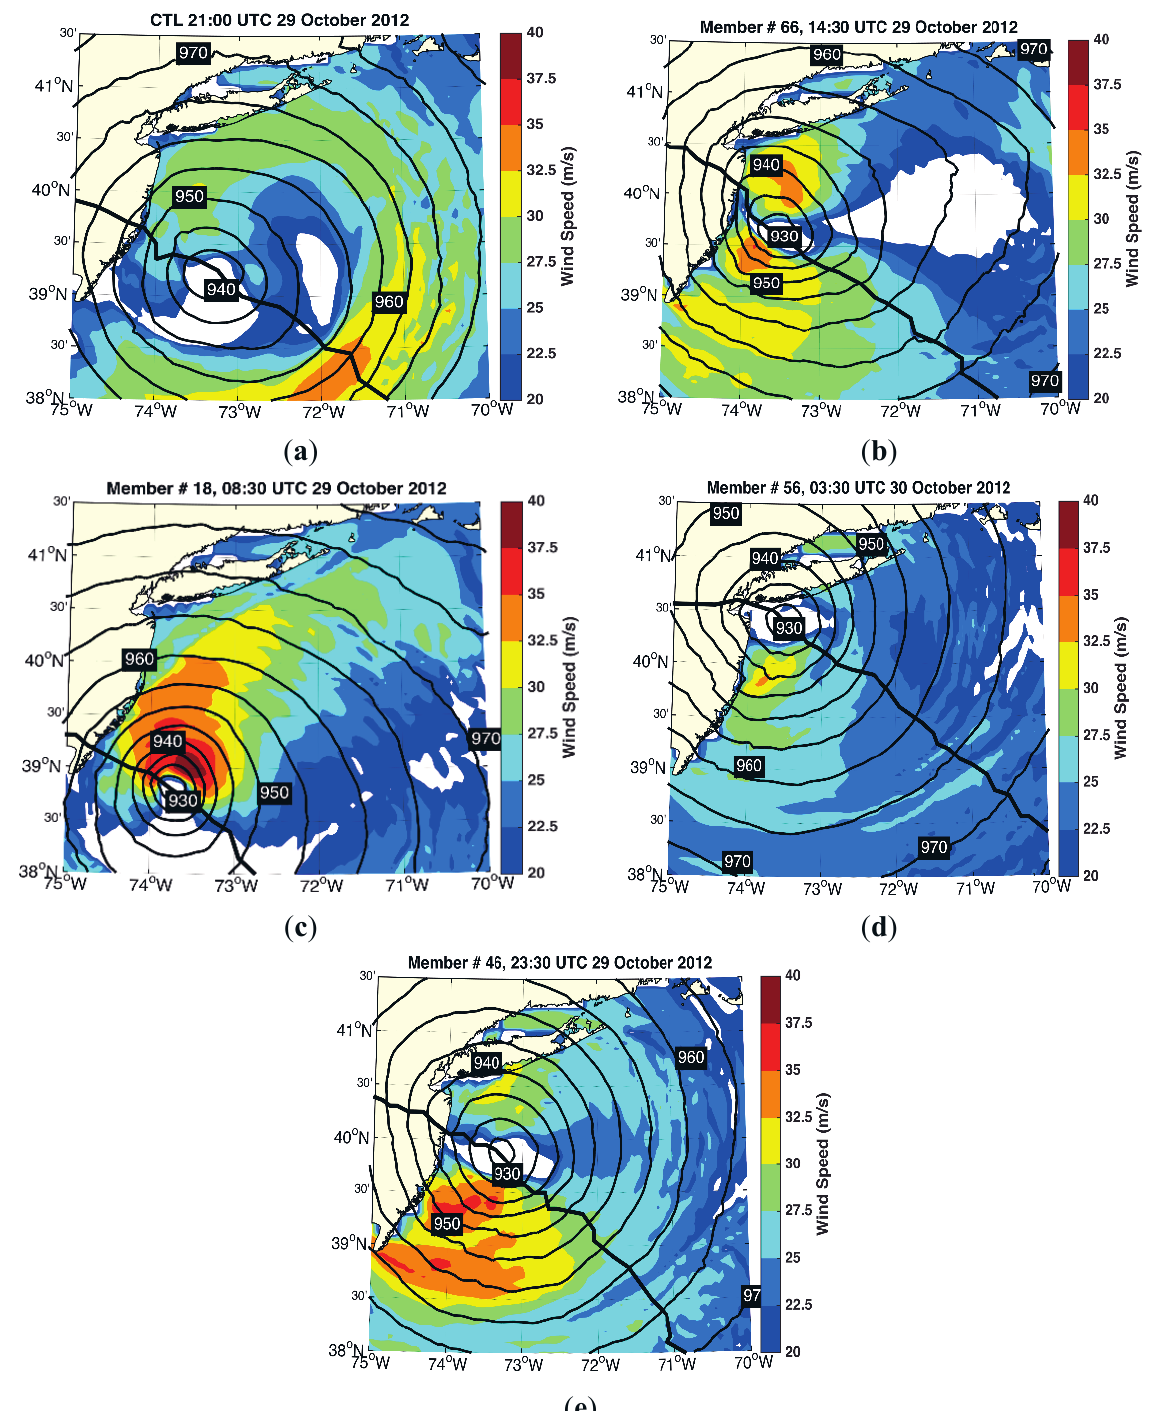
Figure 8. Mean sea-level pressure (every 10 hPa) and surface winds (color coded in m s − 1 ) for the ( a ) CTL; ( b ) 66; ( c ) 18; ( d ) 56; and ( e ) 46 members about an hour before landfall. The black line shows the track of the storm